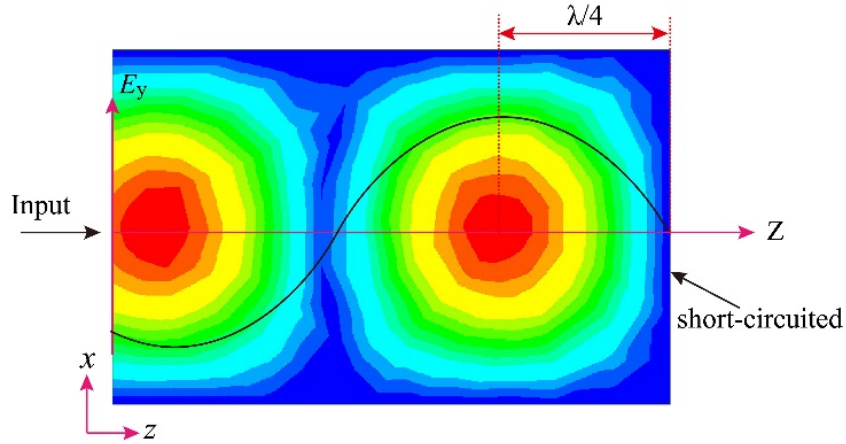
Figure 2. The electric field distribution of short-circuited waveguide.